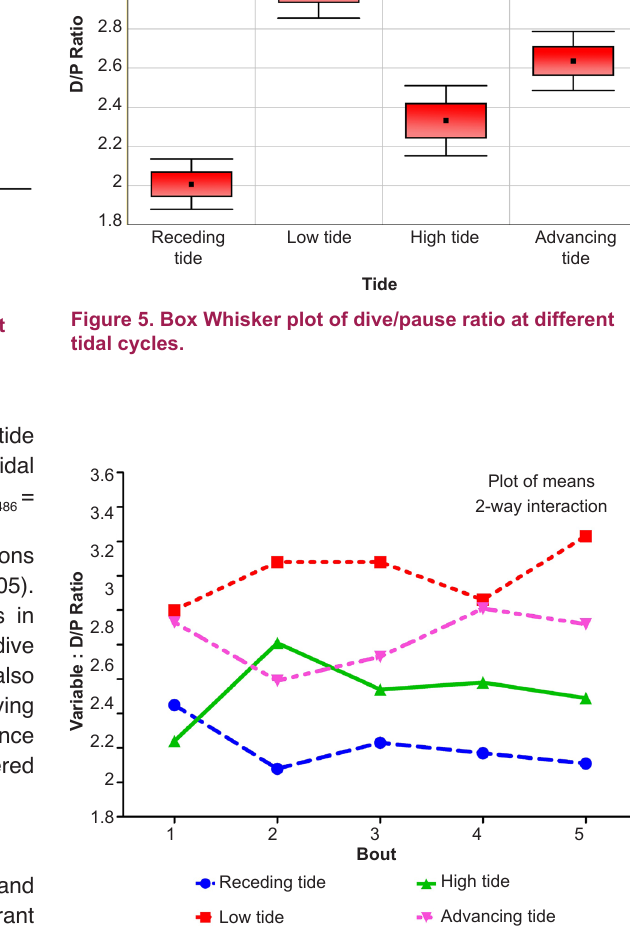
Figure 6. The relation between dive/pause ratio during different tidal cycles.